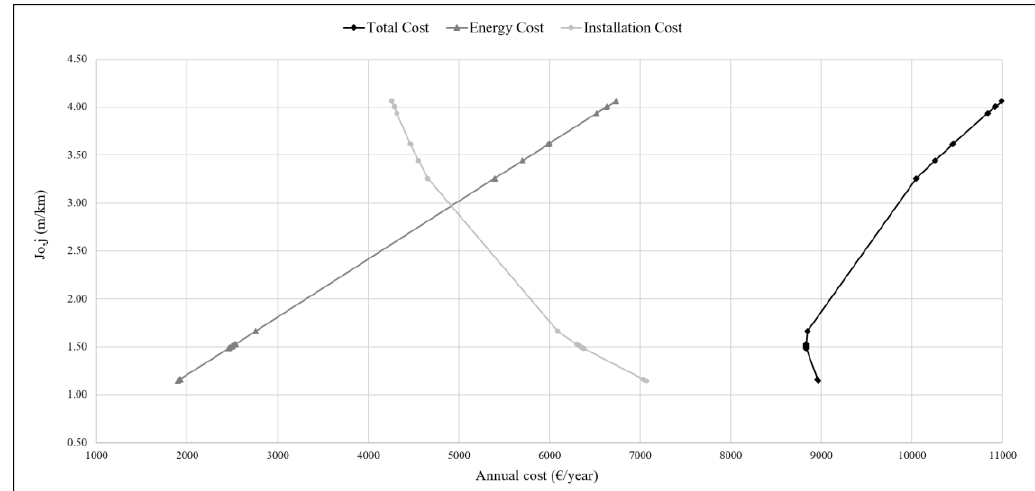
Figure 5. Cost variation as a function of hourly J 0 ,j .